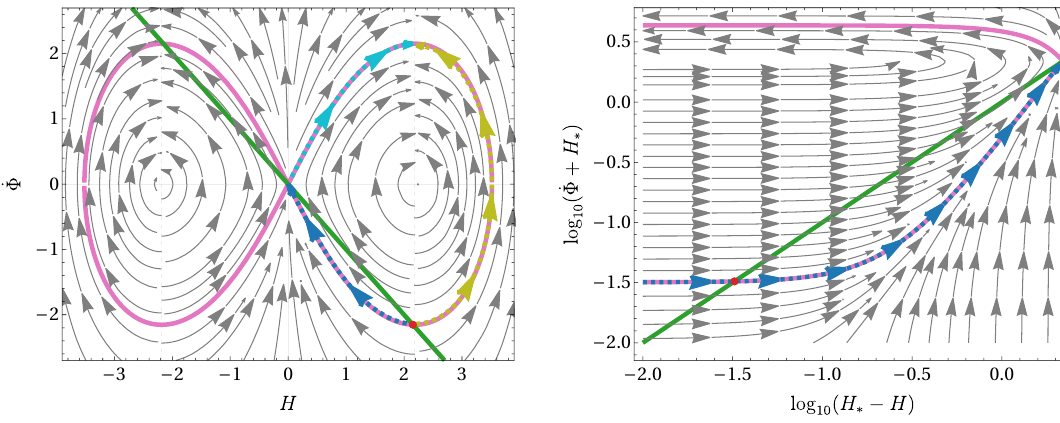
Figure 3 . Phase space diagram for the ansatz (4.13) obtained from eqs. (4.11)–(4.12) in vacuum (so with ¯ ρ = w = λ = 0 ). The same conventions as in figure 1 are used. The plot on the right shows the same content as the plot on the left, except that it zooms in closer to the red dot and uses logarithmic scales for both axes. For this illustrative purpose, the horizontal axis in reflected (i.e., it is a function of − H ), and both axes are shifted by an amount − H ∗ , where H ∗ ≈ 2 . 15 is the point at which the singularity in the EOMs is reached. See text for more details.